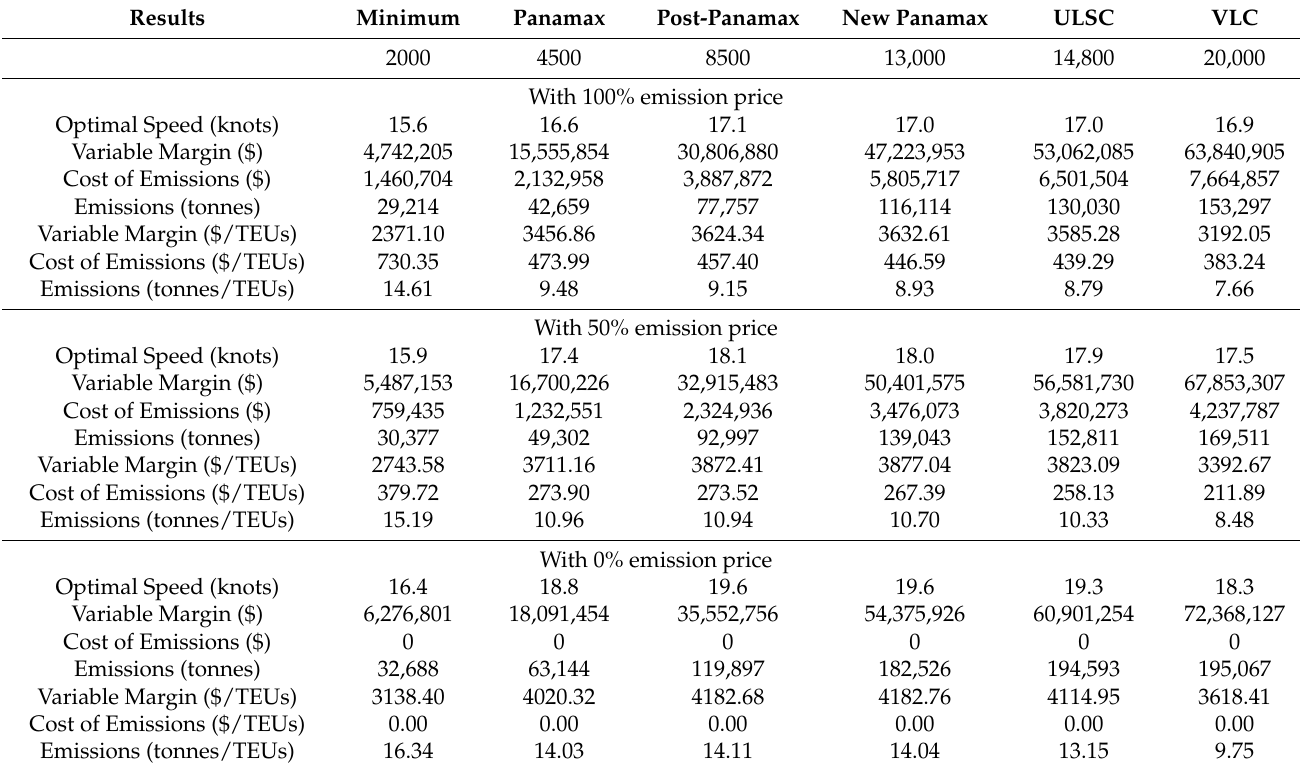
Table 10. Optimal behaviour of selected vessels with a carbon price of $50/tonne.